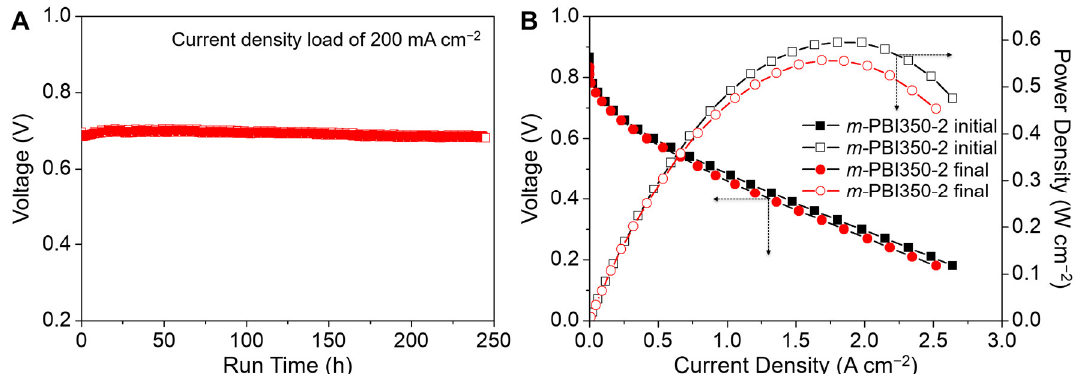
Figure 7. ( A ) Fuel cell performance of m -PBI350-2 with respect to time at a constant current density. ( B ) Cell performances before and after the durability test.